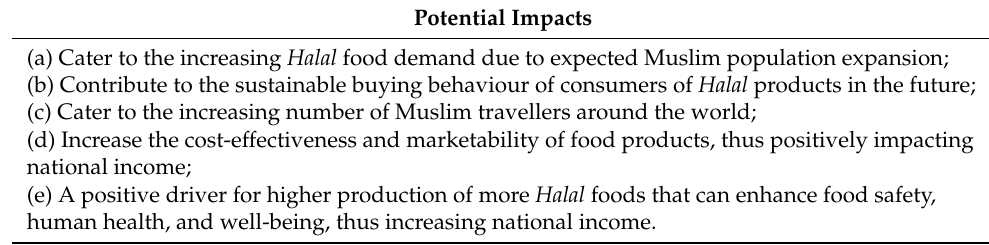
Table 2. The potential impacts of Halal -certified biofertilizers from a socio-economic perspective. Potential